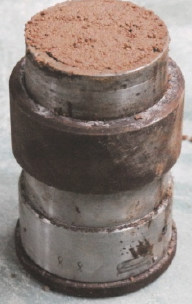
Figure 6: Different